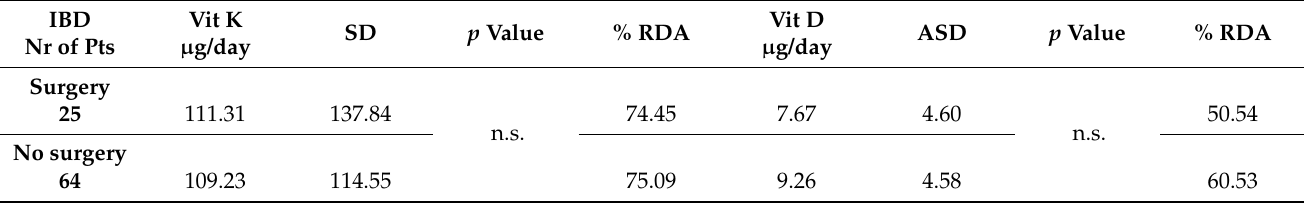
Table 6. Vitamin K and D intake and surgery in CD.